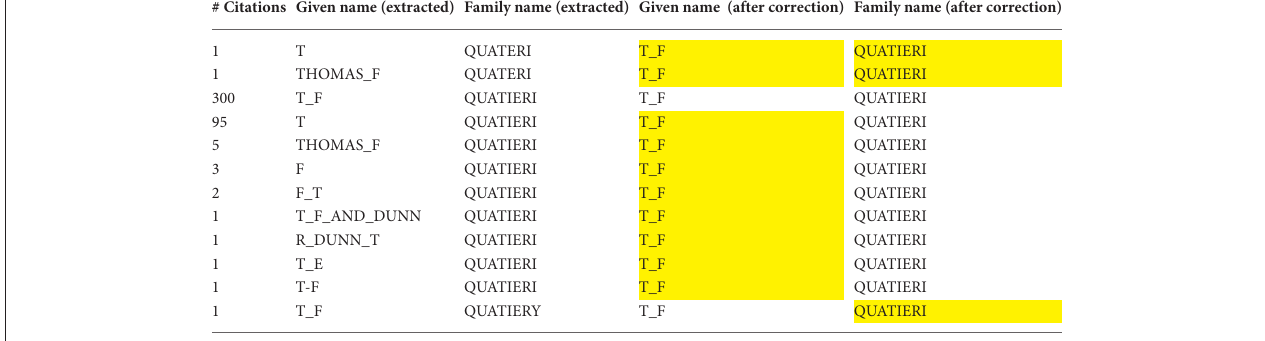
FIGURE 9 | Example of cleaning cited authors’ given names and family names: the case of T.F. Quatieri.